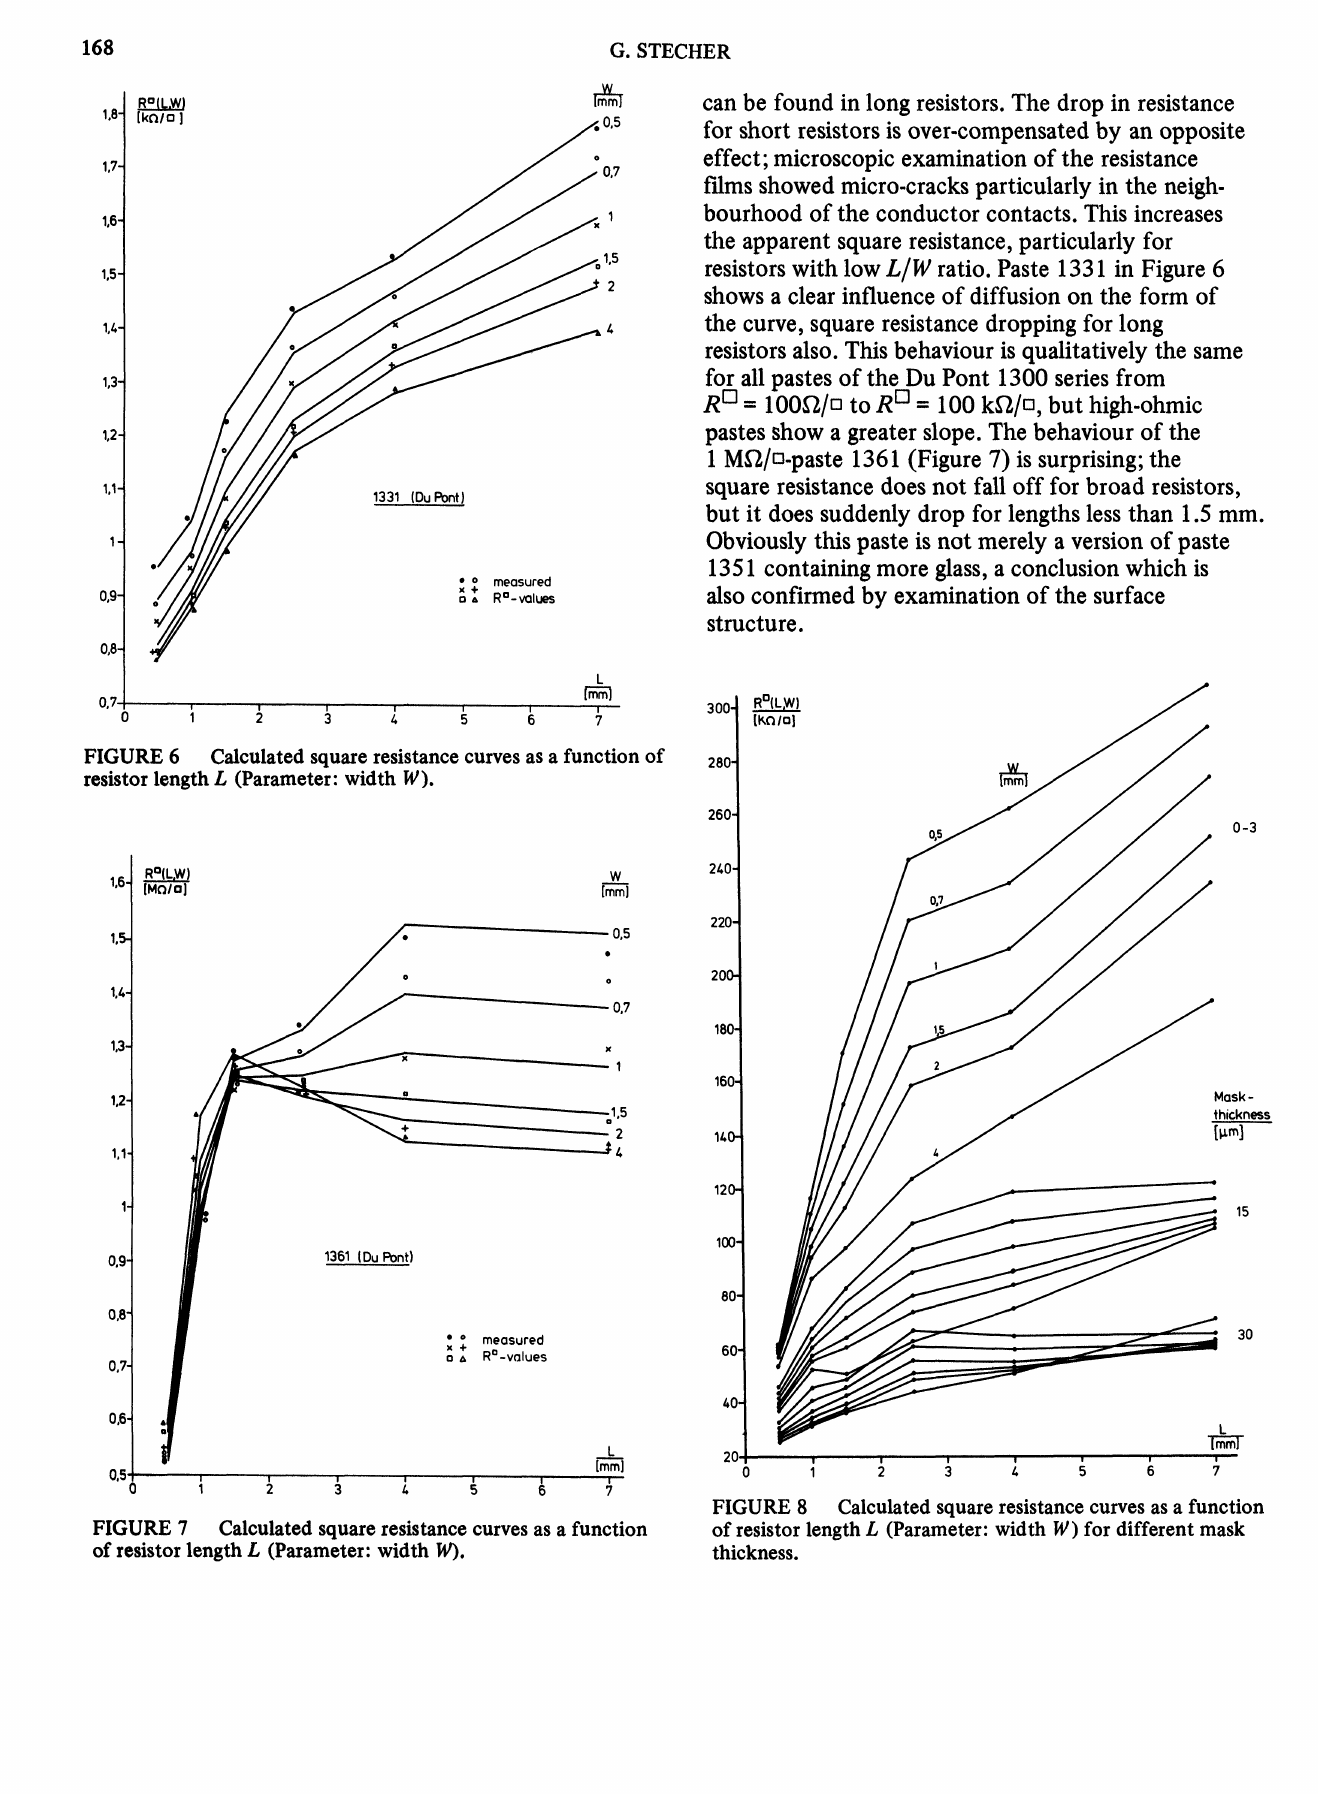
Calculated square resistance curves as a function of resistor length L (Parameter: width W).